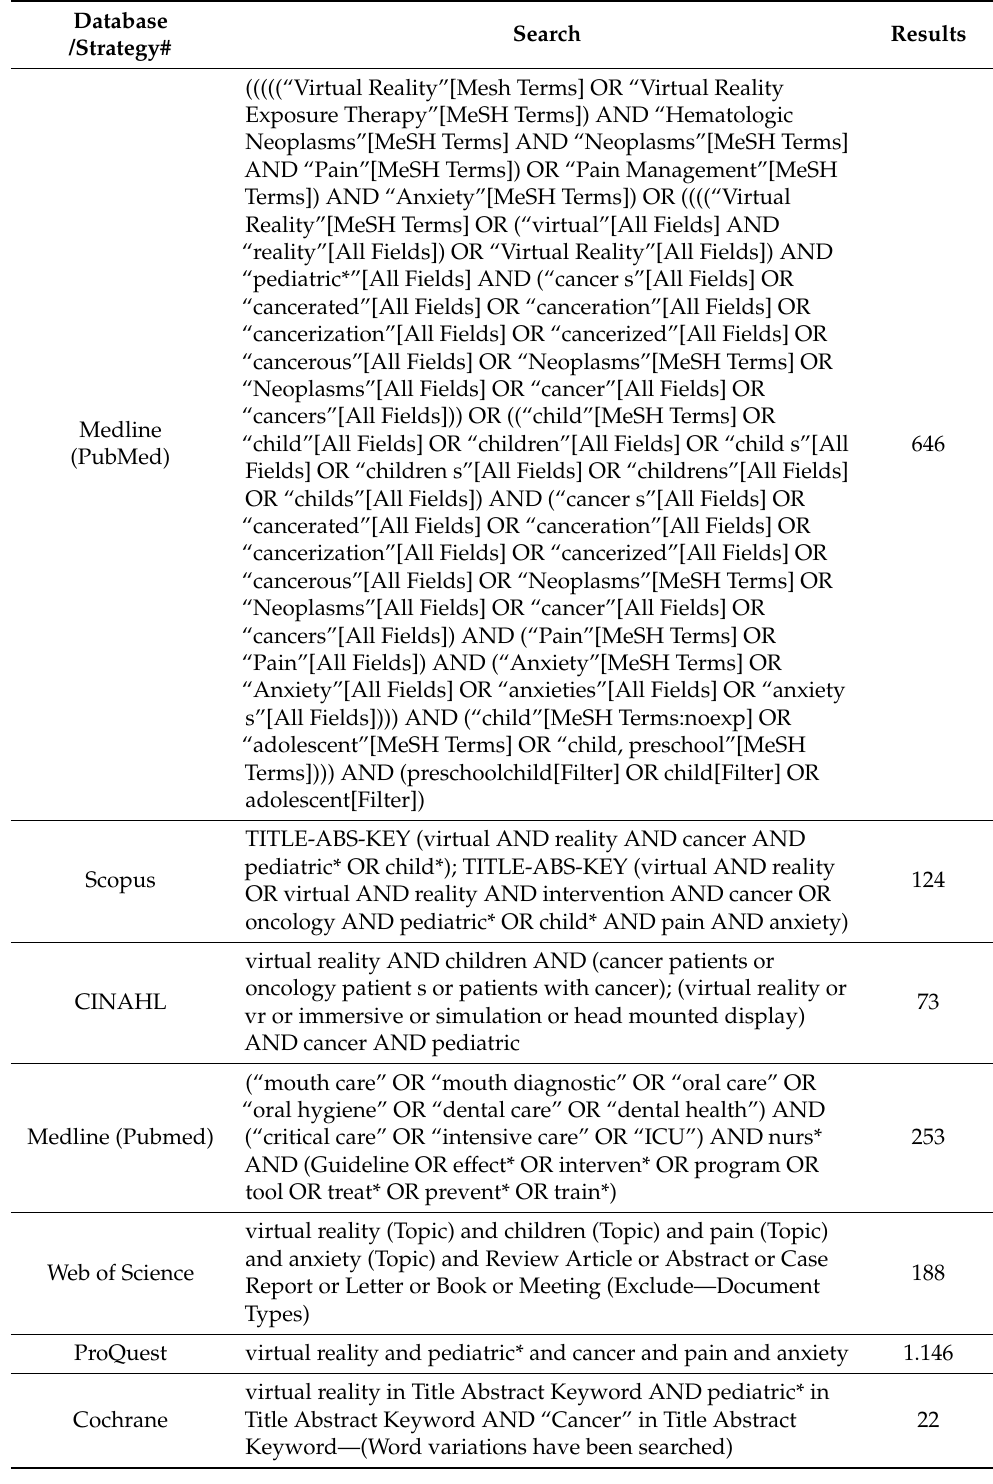
Table 1. Literature search of the electronic